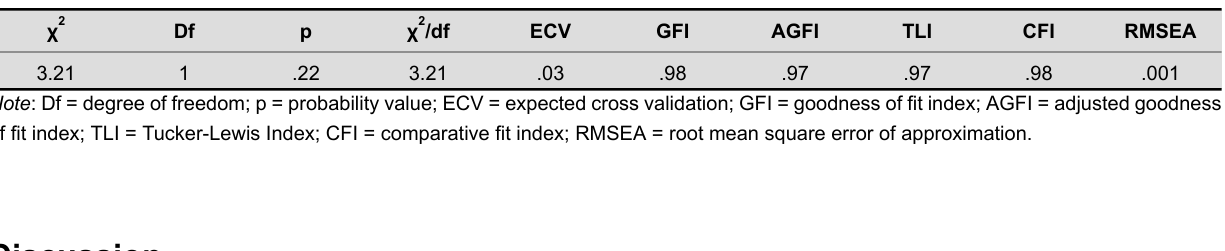
Measures of Fit for the Structural Equation Model of Rejection